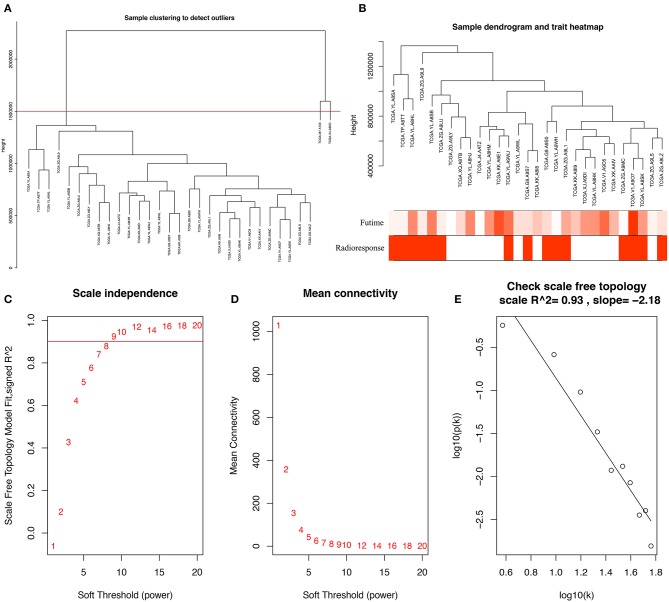
(A) Clustering dendrogram of 31 samples, and excluding two outlier sample. (B) Clustering dendrogram of 29 samples corresponding to clinical characteristics. (C) Analysis of the scale-free fit index for various soft-thresholding powers (β). (D) Analysis of the mean connectivity for various soft-thresholding powers. (E) Checking the scale-free topology when β = 9.